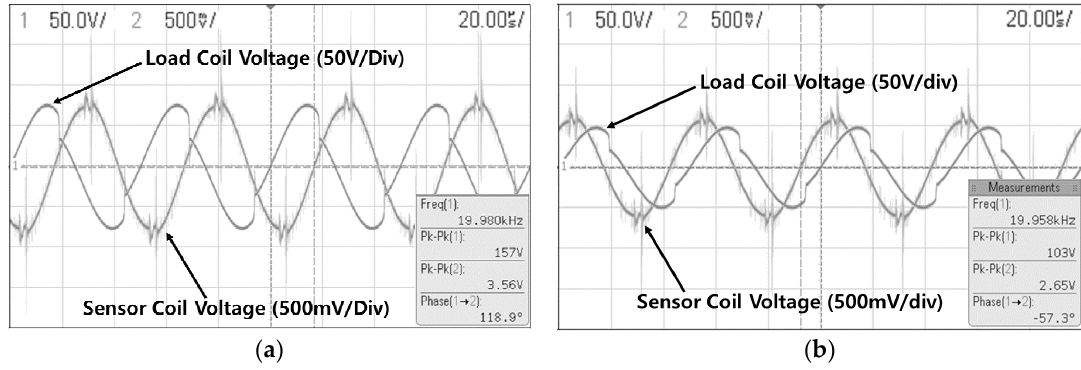
Figure 21. Oscilloscope readings from the first experiment showing the voltage waveform of the load coil and the sensor coil unit at ( a ) left misalignment; and ( b ) right misalignment.